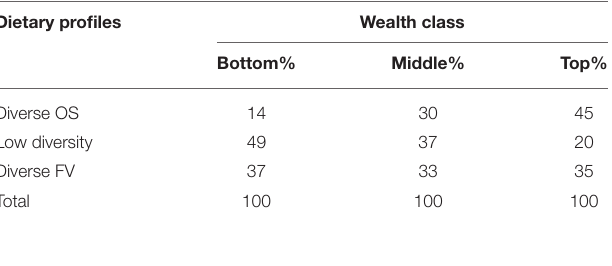
Dietary profiles